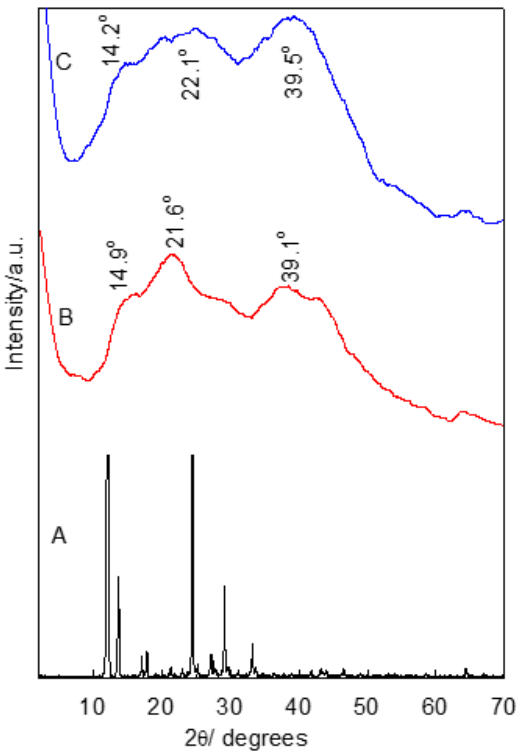
Figure 10. XRD diffraction spectra of MET ( A ), CS-AlgNPs ( B ) and MET-CS-AlgNPs ( C ). 356 Figure 10. XRD di ff raction spectra of MET ( A ), CS-AlgNPs ( B ) and MET-CS-AlgNPs ( C